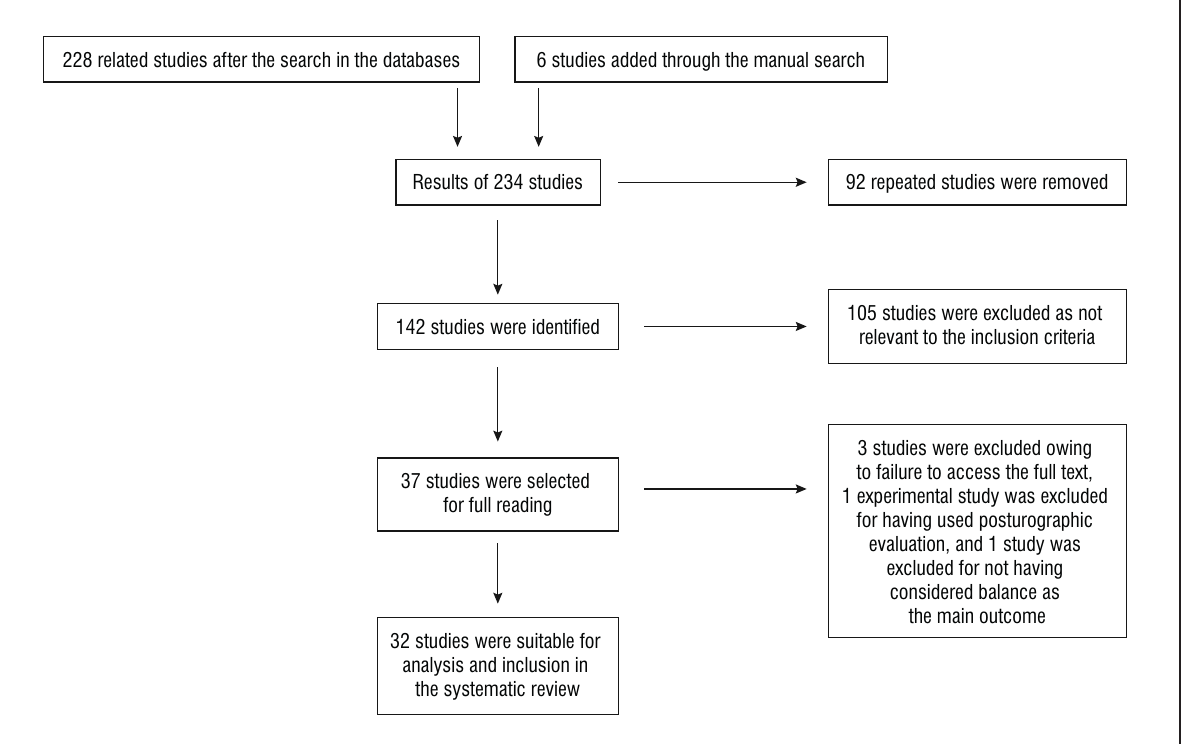
Figure 1 - Identification and selection of the studies for systematic